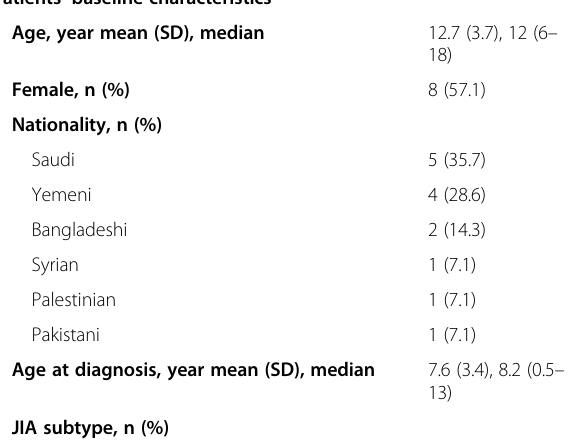
Table 1 Patients ’ baseline and clinical characteristics and medications used before